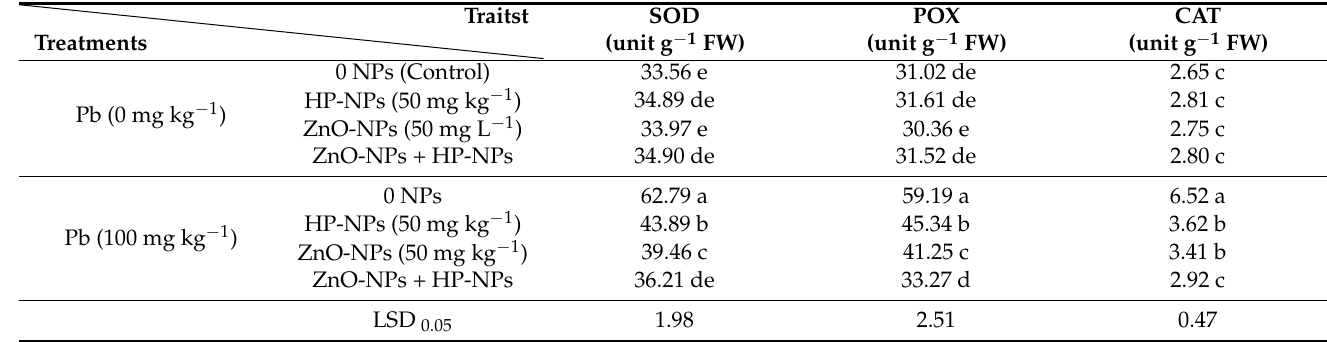
Table 4. Effects of nano-hydroxyapatite NPs (NH NPs), zinc oxide NPs (ZnO-NPs), and their combinations on antioxidant enzymes (superoxide dismutase (SOD), guaiacol peroxidase (POX), and catalase (CAT)) of maize grown in soil contaminated with lead